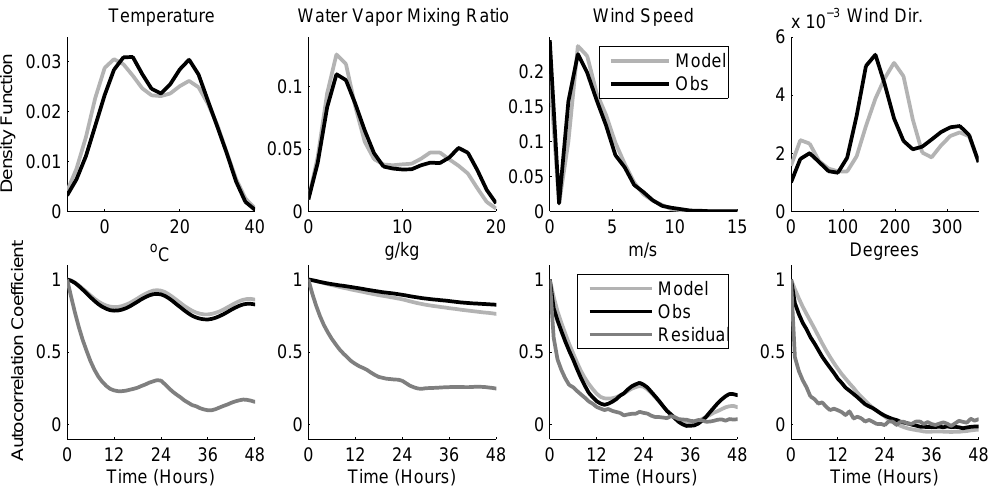
Figure 6. Top: probability density function of temperature, water vapor, wind speed and wind direction observations and simulations at KCPS. Bottom: autocorrelation coefficient of observations and simulations as well as of the residual between the two.